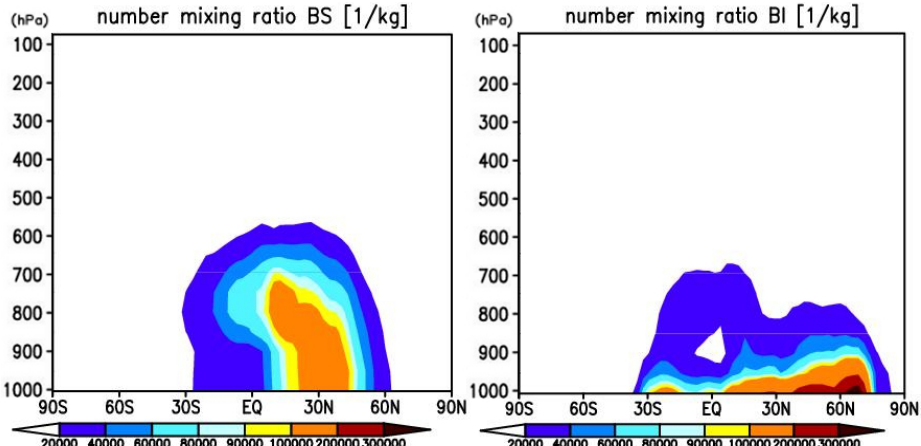
Fig. 3. Modelled (BT1, see Table 1 for description) annual zonal mean vertical profiles of bacteria soluble (BS) and insoluble (BI) number mixing ratios [kg − 1